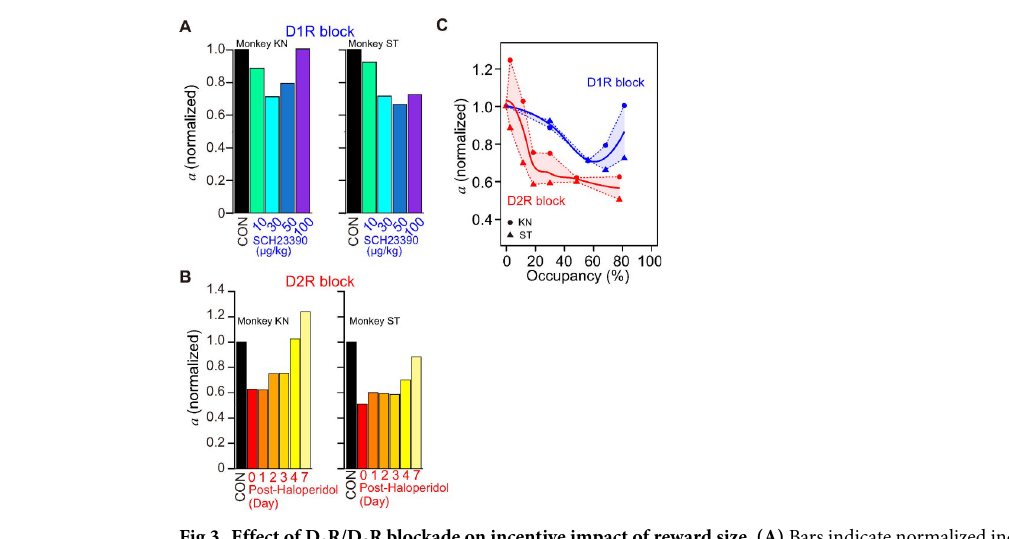
Fig 3. Effect of D 1 R/D 2 R blockade on incentive impact of reward size. (A) Bars indicate normalized incentive impact ( a ) for each treatment condition under D 1 R blockade for monkeys KN and ST. The value was normalized by the value of control condition. (B) Same as A, but for D 2 R blockade. (C) Relationship between an incentive impact and occupancy for